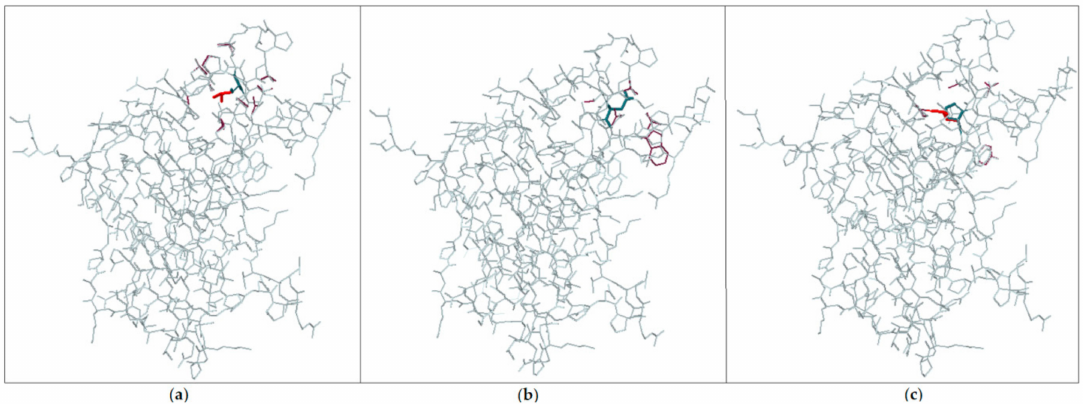
Figure 2. Prediction model of the SYT2 protein: ( a ) with mutation Ser306Leu; ( b ) with mutation Asp307Ala; ( c ) with mutation Pro308Leu; wild type is highlighted with gray and blue; mutant is highlighted with red and dark